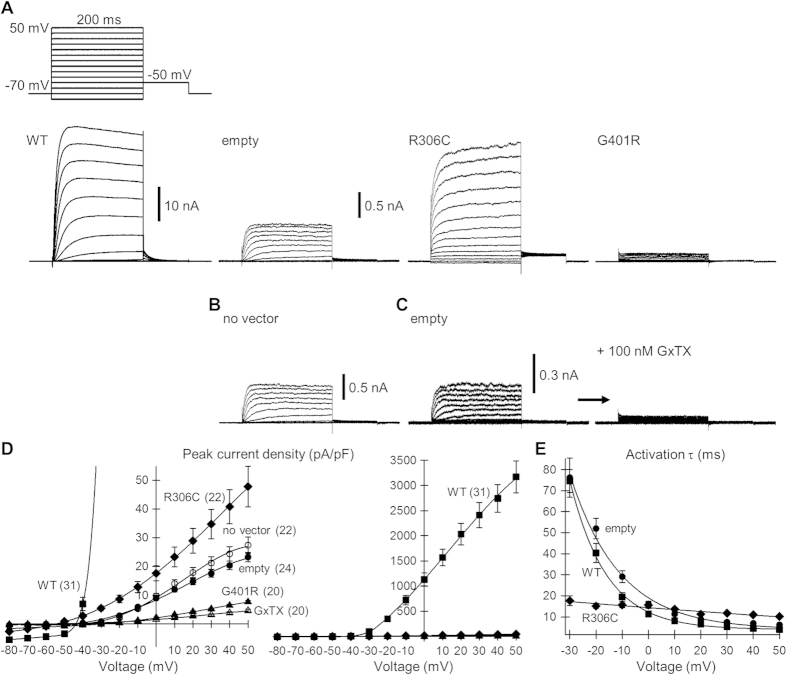
I–V relationships and activation τs of Kv currents in Kv2.1 mutant-transfected Neuro2a cells.(A) Representative currents in cells transfected with WT Kv2.1, empty vector, R306C and G401R mutants of Kv2.1. All currents were elicited with the voltage steps in 10 mV increments from the holding potential of −70 mV, as depicted above the WT trace. (B) Currents in untransfected cells (no vector). (C) Currents in empty were abolished by bath application of 100 nM GxTX. (D) I–V relationship of peak current densities during voltage steps. The relationship in WT (solid squares) is shown in the right panel on a larger scale because of its greater magnitude. The relationship in no vector (open circles) was not statistically different from that in empty (solid circles, P = 0.90 for current density at +50 mV), whereas R306C (solid diamonds), G401R (solid triangles), and GxTX (open triangles) were significantly different from empty at a current density of +50 mV (P = 0.025 vs R306C, P < 0.01 vs G401R and GxTX by Dunnett’s T3 test). The numbers of cells analyzed are indicated in parentheses. (E) Voltage dependence of activation τ. τs in empty and WT were determined by fitting the initial current rising phase from 20% of the peak rise to single exponentials. Currents in R306C were similarly fitted to double exponentials and the initial faster τs plotted. τs at −30 and −20 mV in R306C were smaller than in WT (P < 0.01 by Dunnett’s T3 test), whereas at +50 mV it was larger than in WT (P < 0.01 by REGW test).